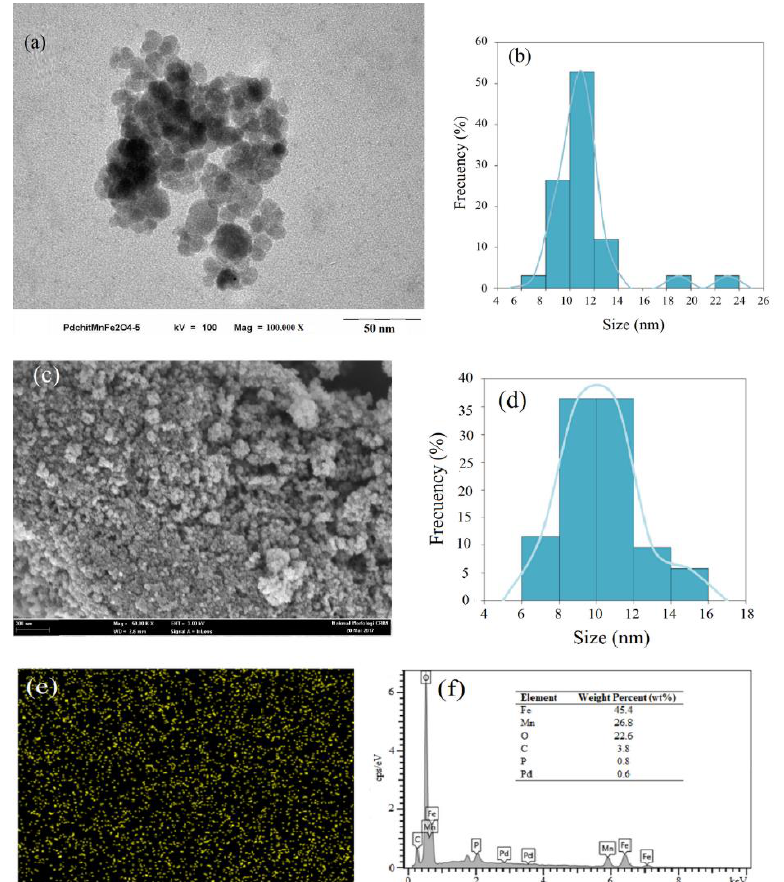
Figure 2. ( a ) TEM micrograph of Pd-Chit@MnFe 2 O 4 , ( b ) the size distribution histogram from TEM micrograph, ( c ) TEM micrograph of Pd, ( d ) the size distribution histogram from TEM micrograph,